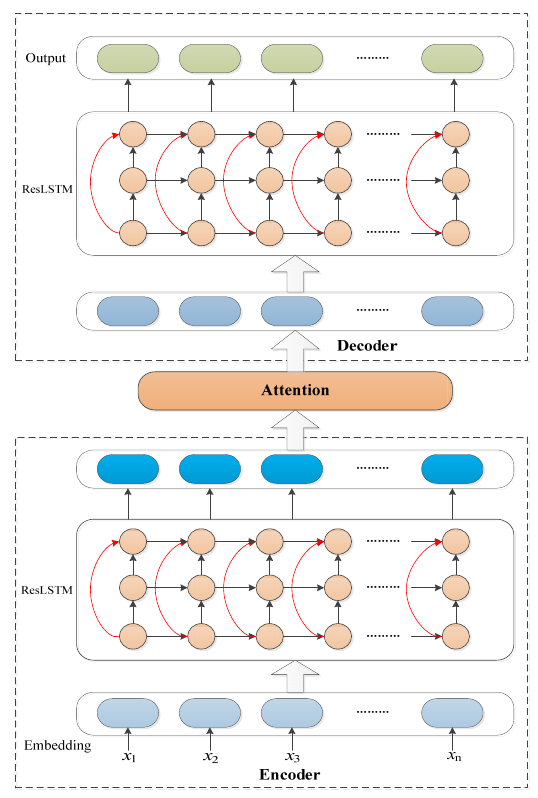
Figure 2. ResLSTM-Attention-Seq2seq Structure.